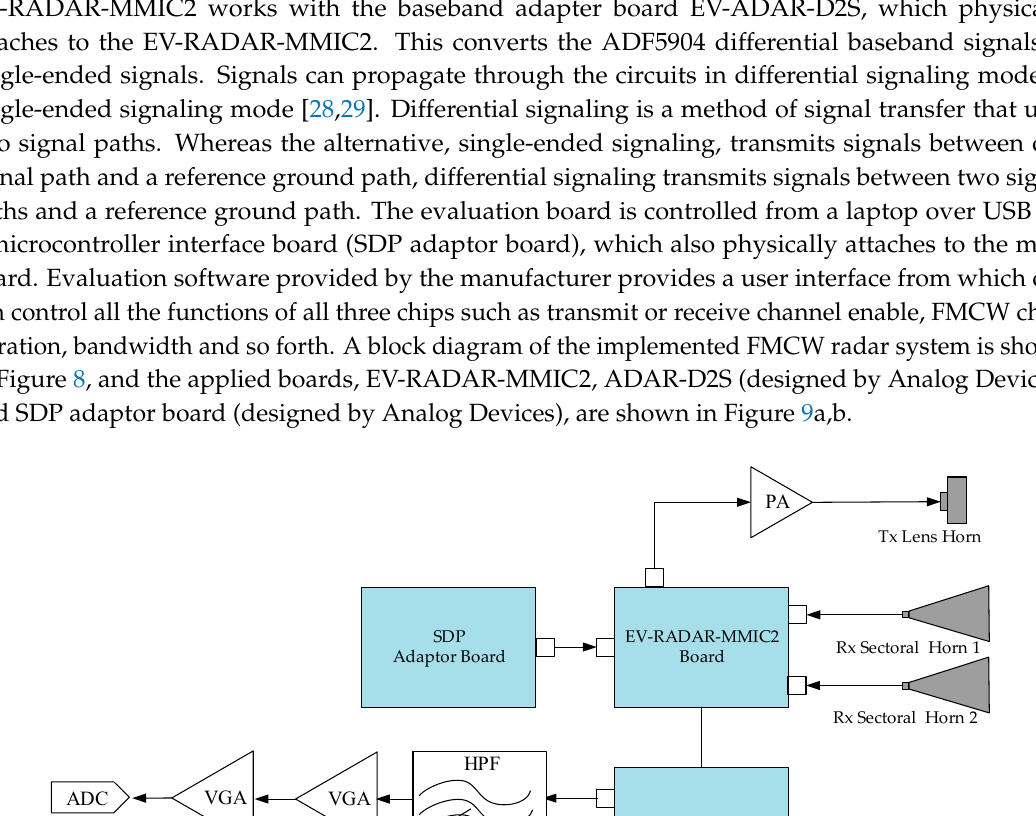
10 of 21 Figure 7. Measured Rx E-plane sectoral horn antenna radiation pattern (normalized).